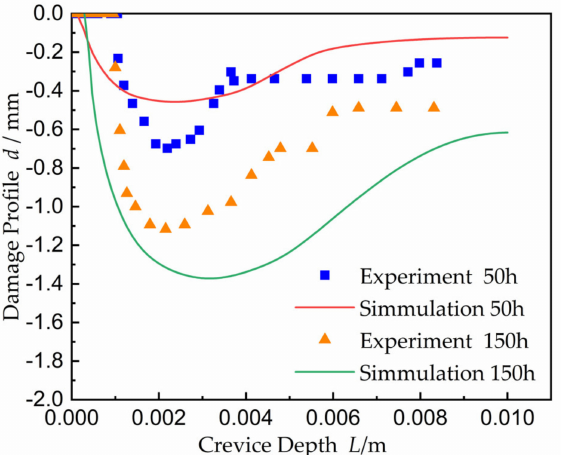
Figure 11. Comparison damage evolution with the result from Abdulsalam [35]. The applied potential at time 50 h is 0.25 V, and the potential of the 150 h is 0.30 V.